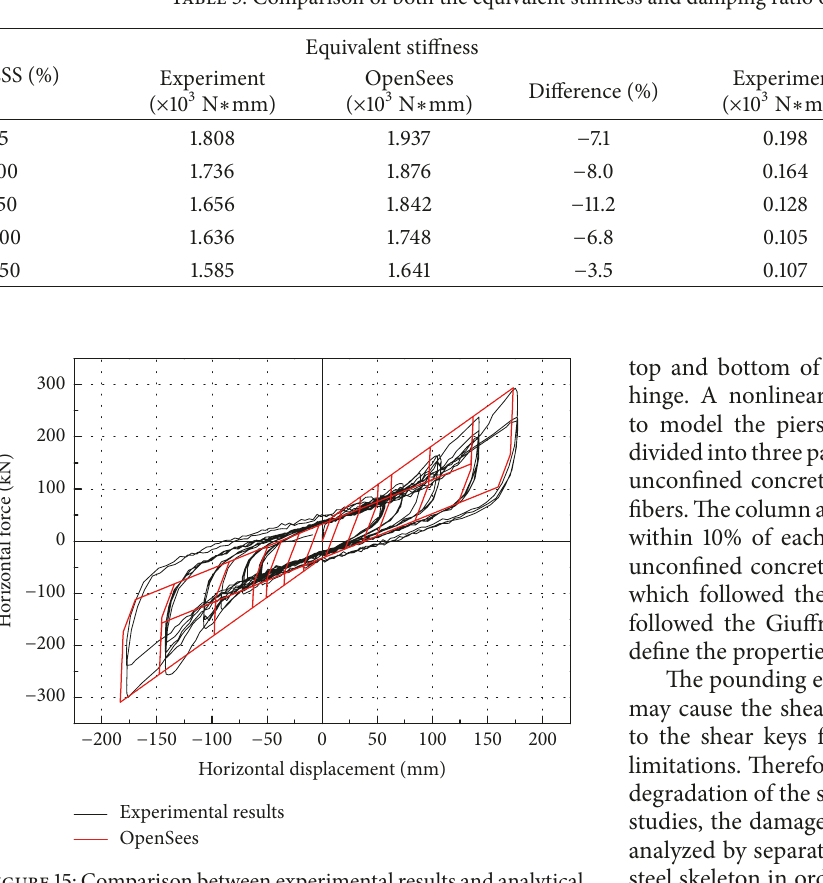
Figure 15: Comparison between experimental results and analytical results of specimen